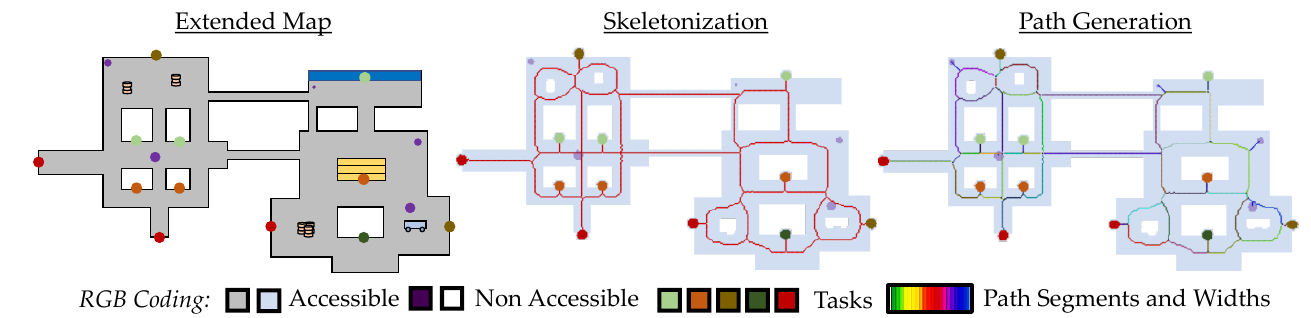
Figure 17. Map extension: RGB map, skeletonization of the extended map, path generation of the extended map.